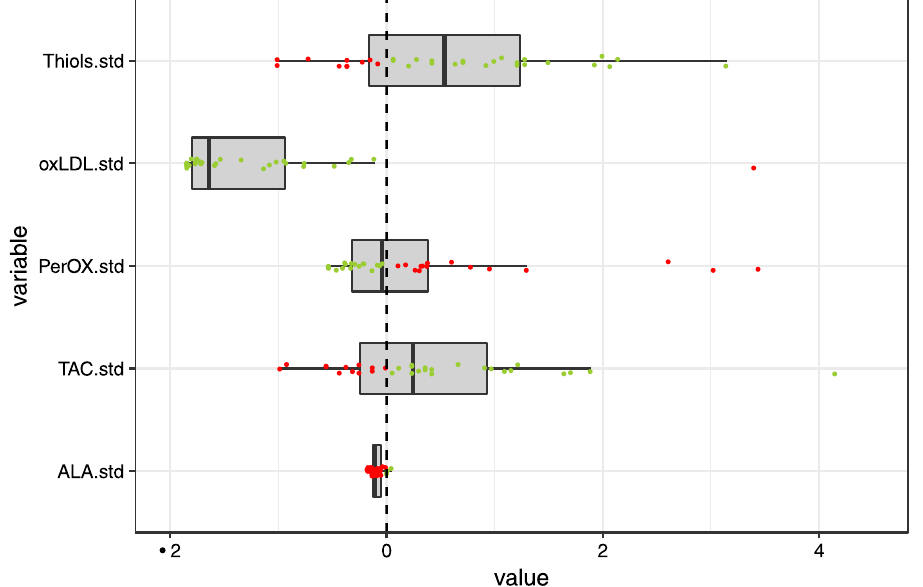
Figure 2. Standardized (= .std) baseline values of mitochondrial function markers with a single cut-off. Values are standardized such that zero (the dashed line) indicates the normal cut-off, 1 indicates one standard deviation, 2 indicates two standard deviations, etc. Green dots indicate values within normal range, red dots indicate values outside the normal range. For alpha lipoic acid one very extreme value (5.6) has been removed for better visualisation. ALA = Alpha-lipoic acid; ox-LDL = oxidised LDL; PerOx = total lipid peroxide; TAC = total antioxidant capactity.